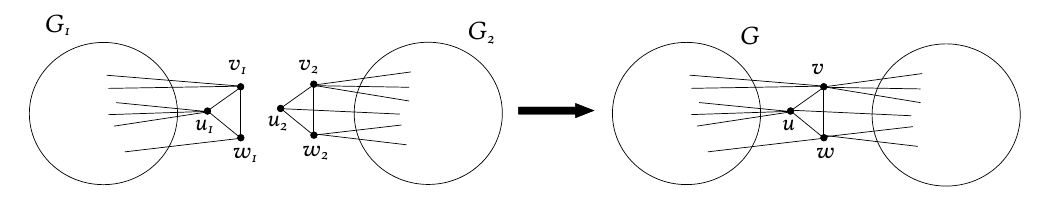
Fig. 10: The triangle identification